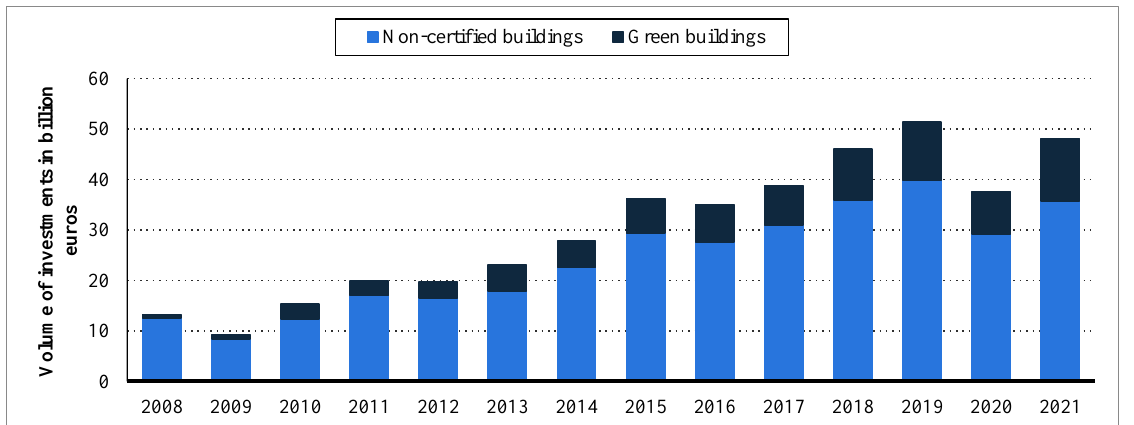
Figure 1. Investments in green and non-certified buildings in Germany from 2008 to 2021. Source: BNP Paribas Real Estate; ID 1294695.